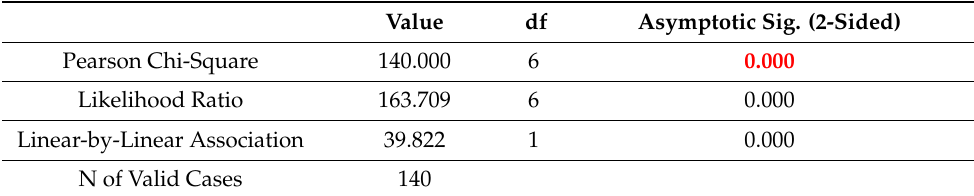
Table 15. The results for Chi-Square bivariate